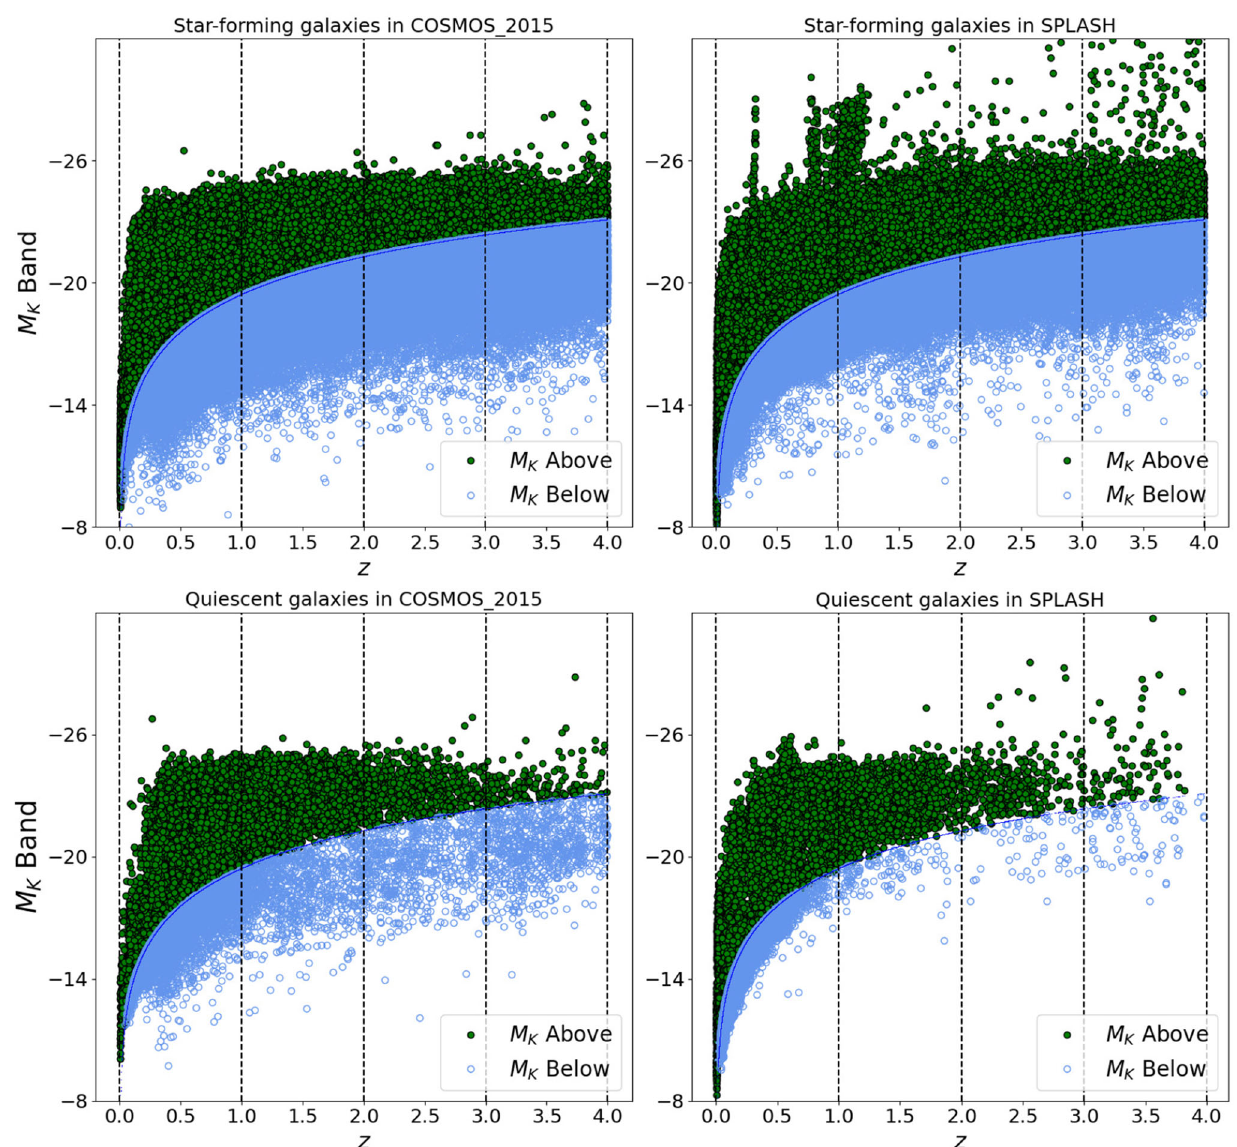
Fig. 11 Plots of the absolute magnitudes for the blue star forming galaxies (top), and red quiescent ones (bottom) for the COSMOS2015 (left) and SPLASH (right) surveys in terms of their photometrically measured redshift values. Specific discriminations are as in the title of each plot. As in Figs. 2 and 3, the dividing line corresponds to apparent magnitude K = 24 . 7, so only blue and red galaxies having M K above